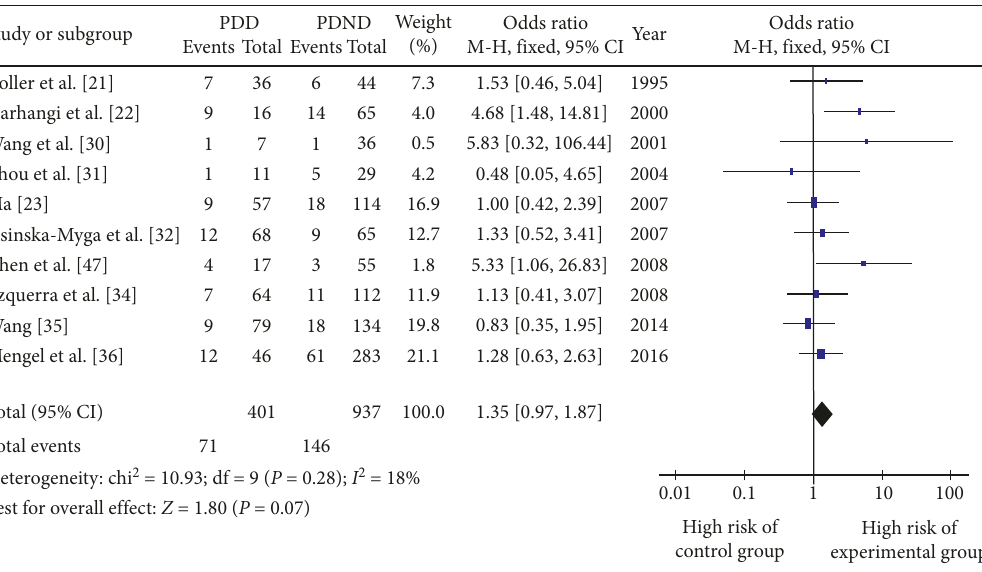
Figure 3: Forest plot for the risk of Parkinson’s disease dementia onset in ε 2+ patients assessed in 10